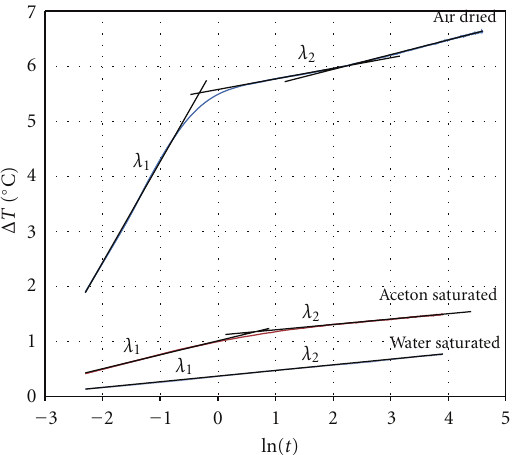
Figure 6: Evolution the Δ T/ ln( t ) curves for 2.8–3.4 mm glass beads in dried, acetone and water saturated states. The shift down of the Δ T/ ln( t ) curves due to the saturation accords with the di ff erence between the thermal conductivities of the air ( λ = 0 . 025 W/mK), acetone ( λ = 0 . 164 W/mK) and pure water ( λ = 0 . 60